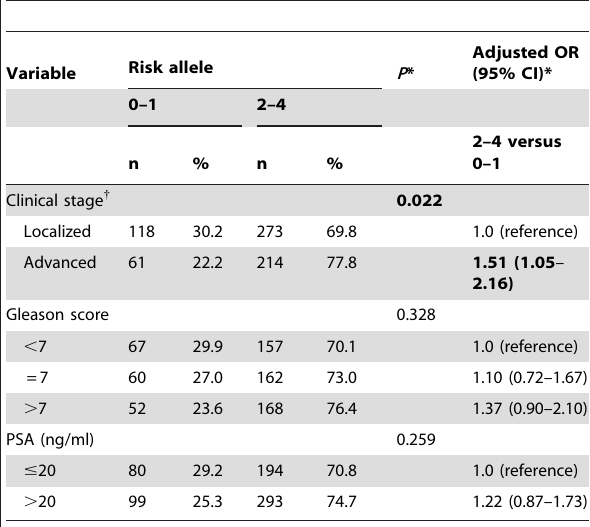
Bold-faced values indicate significant difference. *Adjusted for age, smoking status, drinking status and family history of cancer in logistic regression model; 95% CI: 95% confidence interval; OR: odds ratio. { Clinical staging according to the international TNM system for PCa.